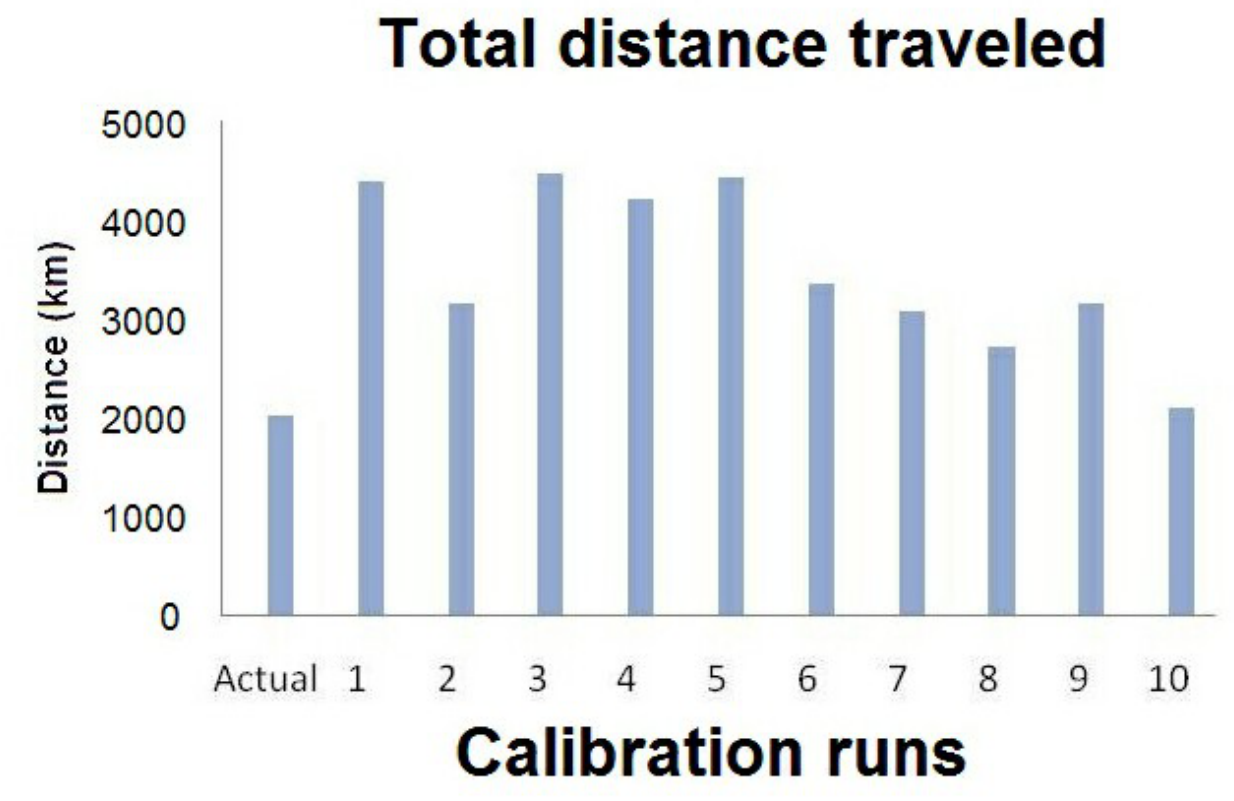
Fig. 6 . The mean distance traveled in the 10 calibration simulations compared to the actual distance traveled by the 12 real moose. Calibration run #8 was the second-best